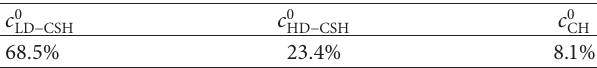
Table 1: Relative volume fraction of phases in cement paste when